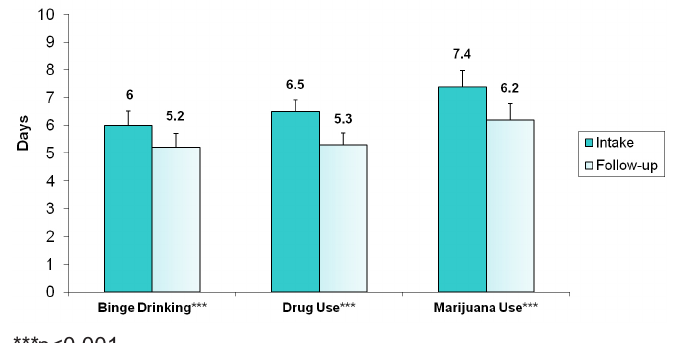
*** p<0.001 Figure 5. Changes in number of days in the past 30 that one binge drank, used illicit drugs, and used marijuana among those at